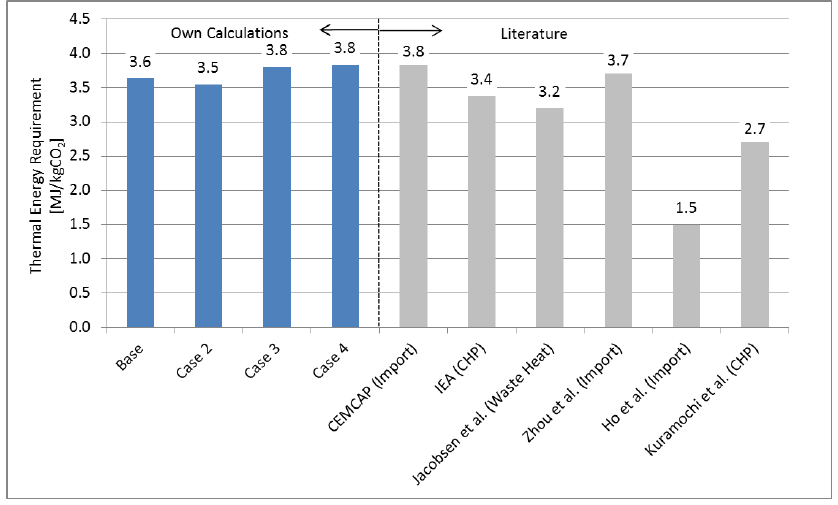
Figure 5. Thermal energy requirement for the present study and the literature (steam sources indicated in brackets).